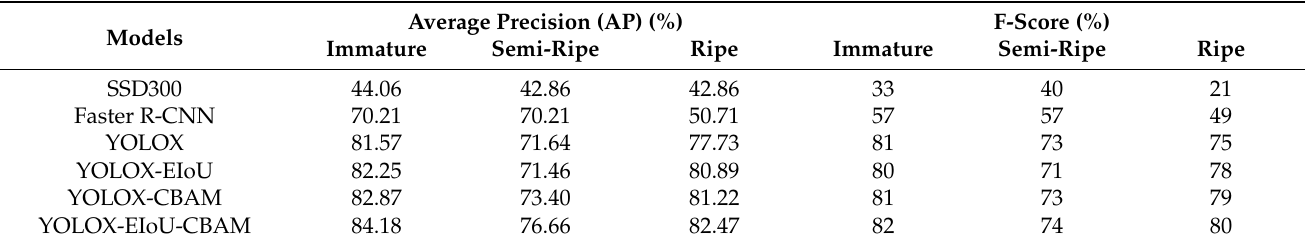
Table 3. Multi-metric performance evaluation (AP and F-score) of six models (SSD300, Faster R-CNN, YOLOX, YOLOX-EIoU, YOLOX-CBAM, and YOLOX-EIoU-CBAM) on 240 test samples at different stages of maturity (immature, semi-ripe, and